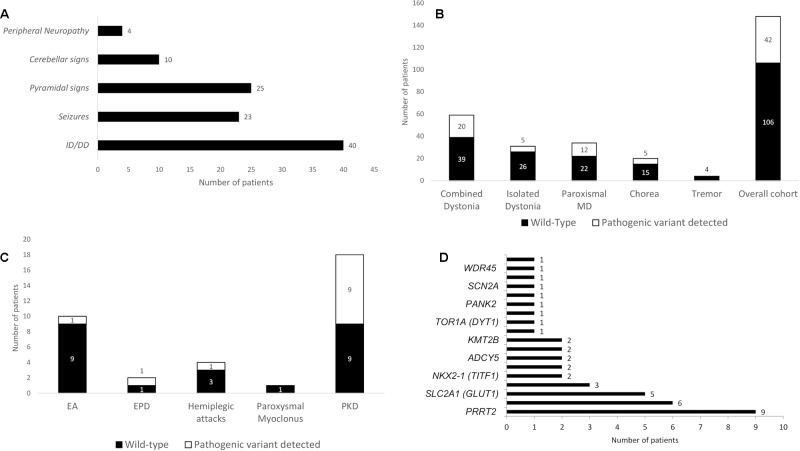
Associated neurological features of the cohort and diagnostic yield of the gene panel analysis. (A) Associated neurological features in the overall cohort. (B) Diagnostic yield in the overall cohort and in the different groups, expressed as total number of patients receiving a definite molecular diagnosis through gene panel analysis. (C) Diagnostic yield of gene panel analysis in paroxysmal MD according with their phenomenological classification. (D) Distribution of pathogenetic variants encountered per gene (see Appendix 2 in the
Supplementary Materials
 for the complete list of genes sequenced in the panel). DD, developmental delay; EA, episodic ataxia; EPD, exercise-induced paroxysmal dyskinesia; ID, intellectual disability; MD, movement disorder; PKD, paroxysmal kinesigenic dyskinesia.